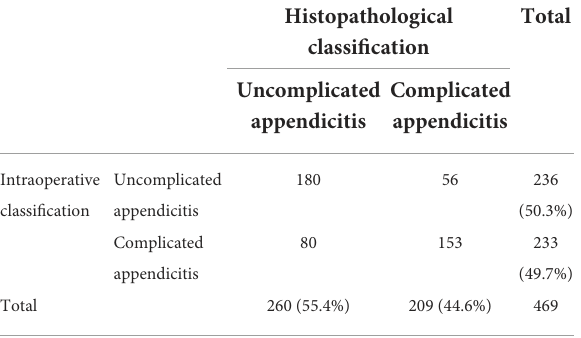
TABLE 2 Agreement between intraoperative and histopathological severity